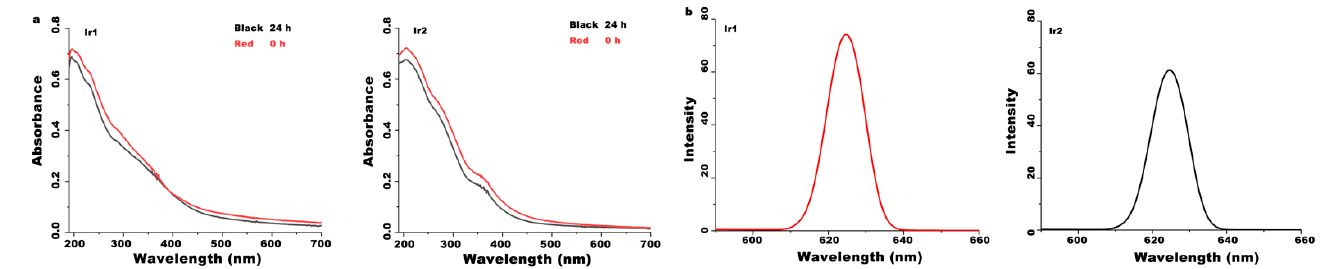
Figure 1. ( a ) The stability detection of the complexes (40 µM) in PBS solution at room temperature. ( b ) Luminescence of the complexes (40 µM) in PBS solution at room temperature.